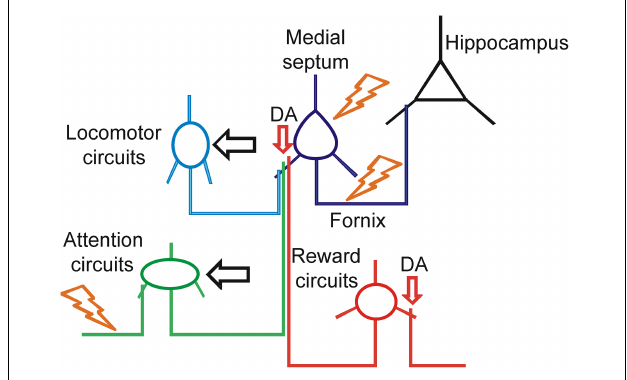
FIGURE 3 | Therapeutic strategies for enhancement of septo-hippocampal signaling. Schematic representation of the translational targets for treatment of basal forebrain impairment (BFI). The orange symbols indicate electric current stimulation with deep brain stimulation (DBS) or vagus nerve stimulation (VNS). The horizontal black arrows indicate physiological activation of the circuits with behavioral motor or cognitive therapy. The vertical red arrows indicate pharmacological targets for enhancement of dopaminergic